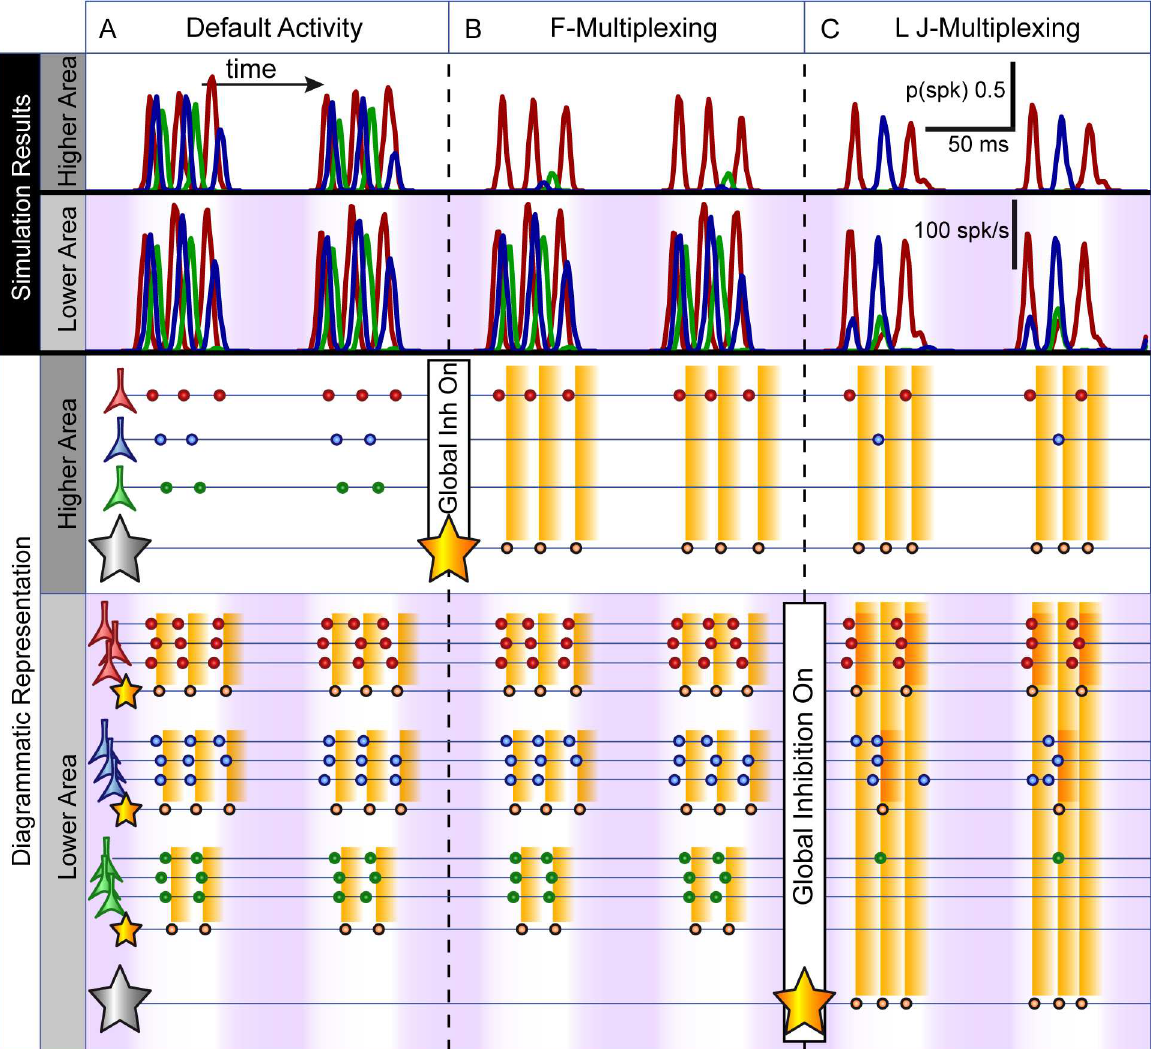
Fig 4. F- and LJ-style multiplexing: simulation results and diagrammatic representation. This figure shows the results of a simulation(100 repeats) in which key parameterswere changed over the course of the simulationin order to illustrate and explainthe different network states highlightedin Fig 3. Simulation results (top of the Fig) show post-stimulus time histograms (PSTHs) for cells in the upper and lower areas, averaged over 100 repeats of the same simulationparameters. The stimulus image was that shown in Fig 2, comprising three discrete objects of different contrast values (see Methods). Parameters were fixed at default values (Fig 3B), except that at successive fixed time points, global inhibitionwas turned on, first in the higher area (Fig 3C) and then in the lower area as well (Fig 3E). Red traces are for the cells responding to the highest contrast object (averagedover all the active cells in the relevant quadrant of the lower area; and showingthe probabilityof firing at a given time point for the single cell in the higher area respondingto that object), and similarly blue for the mid-contrast object and green for the low-contrast. The purple background in the lower area shows the amplitudeof the slow oscillatory inhibitoryconductance. The same colours are preserved in the diagrammatic representation of activity. As in Fig 2, inhibitoryinterneurons,their time of firing and the time course and spatial extent of this inhibitory feedback are indicatedin orange. A . With no global inhibitionin either lower or higher area, activity driven by the three stimulus objects generates independent gamma oscillationsin the lower area, and the higher area simply follows this activity. However, the output is not well temporally segregated. B . Global inhibitionis added to the higher area. On each slow cycle, the first-arriving burst of inputs to the higher area drive a cell which in turn competitively inhibits the other higher area cells. That inhibitiondecays just in time for the same cell to be driven by its next burst of inputs from the lower level (i.e. a PING gamma is set up in the higher area, matching the dynamics of the gamma in the lower area, and selective communication is achieved, or F-multiplexing). C . Global inhibitionis added to the lower area. On each slow cycle, when the first ensemblefires competitive inhibitiondisrupts the activity of the other ensembles. The second ensemble recovers, yieldinga second cycle of inhibition.By that point, the first ensemblehas recovered and fires again, and the third ensemblenever has the chance to fire. Effectively, the independent gamma activities in the lower area are disruptedand replaced by a single global gamma, with activity of just a single ensembleon each